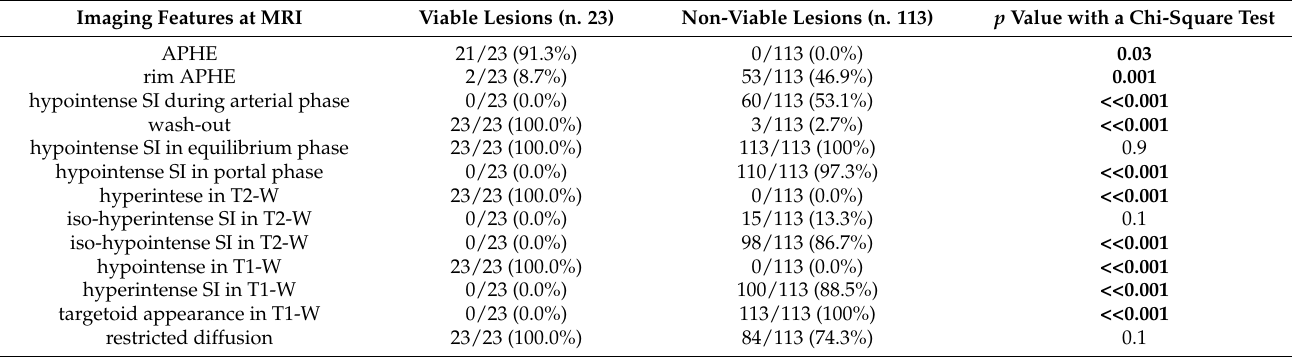
Table 4. Prevalence of imaging features at MRI in viable and non-viable lesions according to conventional and abbrevi- ated studies. Imaging Features at